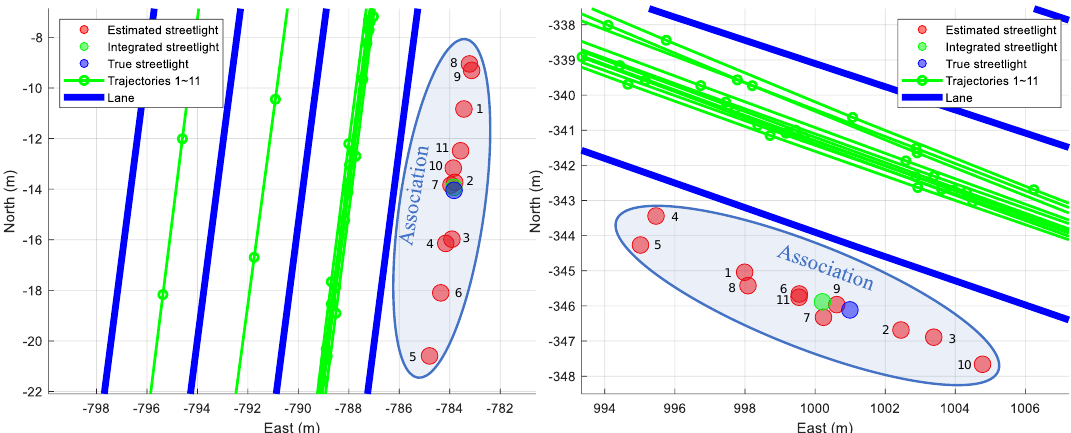
Figure 11. Results of the proposed algorithm in the specific streetlights. The integrated streetlight is updated recursively based on each indexing number beside each estimated streetlight. As a result, the integrated streetlight approximates the true